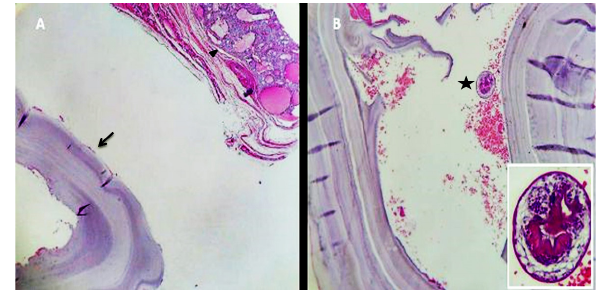
Figure 3: A. Laminated fibrous cyst wall (arrow) adjacent to thyroid tissue (arrow